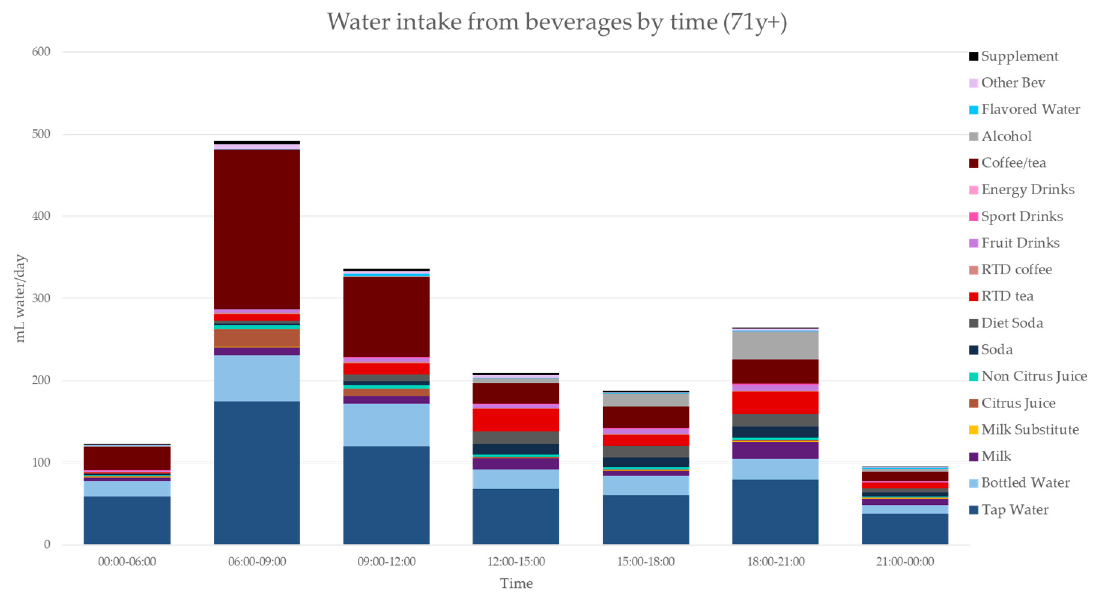
Figure 9. Water intakes (mL / d) by beverage type and time of day for the 71 + y age group (NHANES